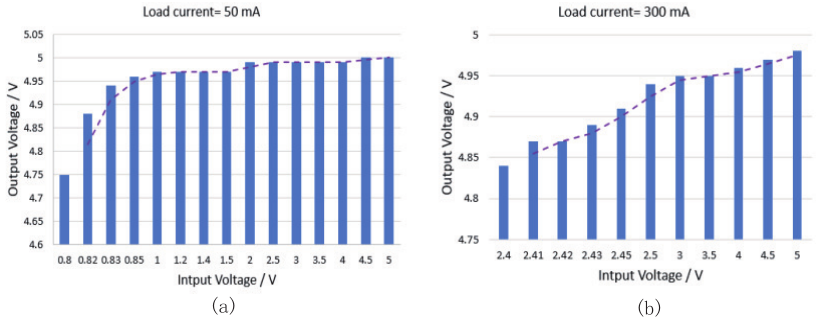
Figure 16. The test results of output voltage variation with input voltage when the load currents is identified. ( a ) The load current is 50 mA. ( b )The load current is 300 mA.